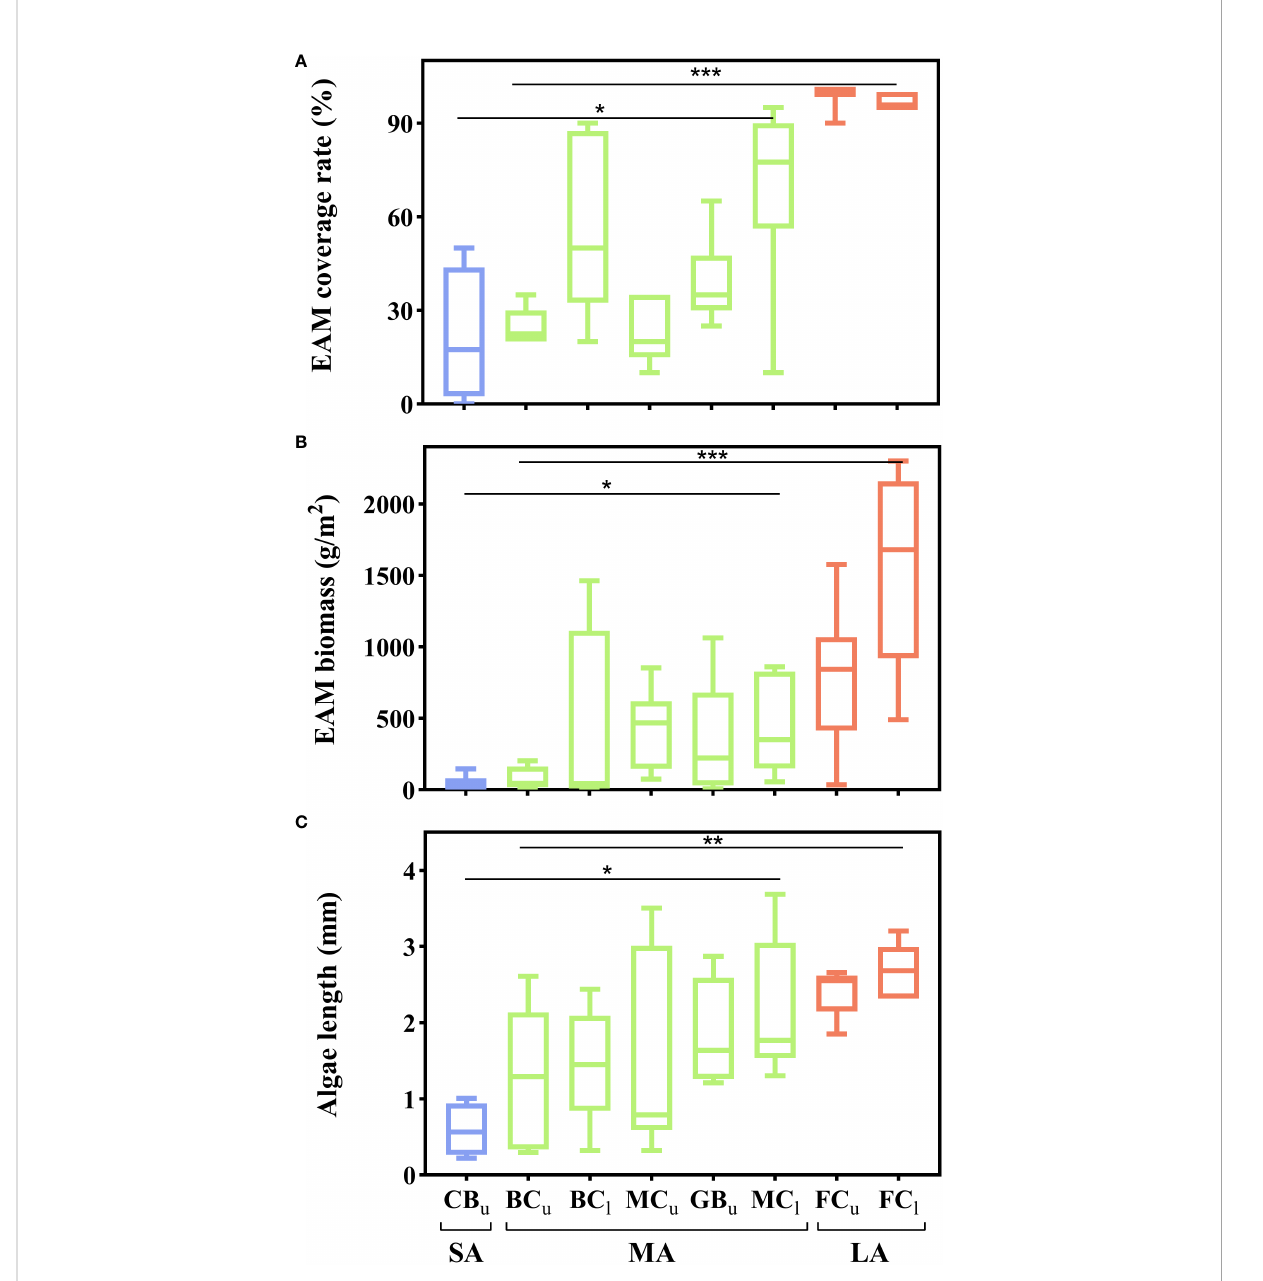
FIGURE 2 EAM morphological characteristics on different substrates. (A) EAM coverage rate; (B) EAM biomass; (C) algal length (The different substrates were divided into three categories: short EAM [SA], medium EAM [MA], and long EAM [LA]. Subscripts indicate different tidal levels, with u and l representing the upper and lower intertidal zones respectively. Asterisks indicate the level of signi fi cance, *: P < 0.05, **: P < 0.01, ***: P <